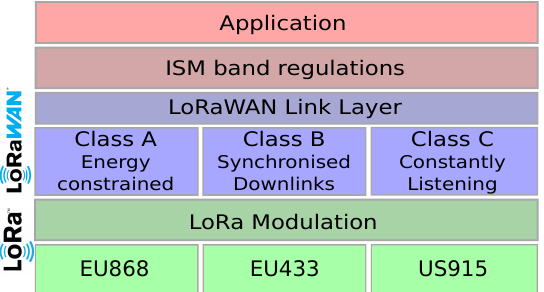
Figure 5. LoRaWAN classes and license-free sub-gigahertz radio frequency bands for the EU and the US. The current LoRa-based standard for sub-GHz transmissions is called